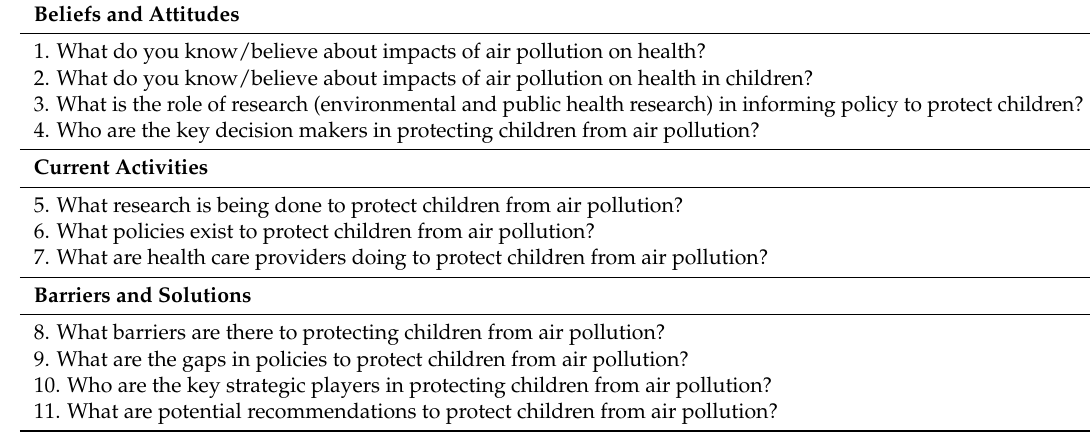
Table 1. Overarching questions and themes for policy